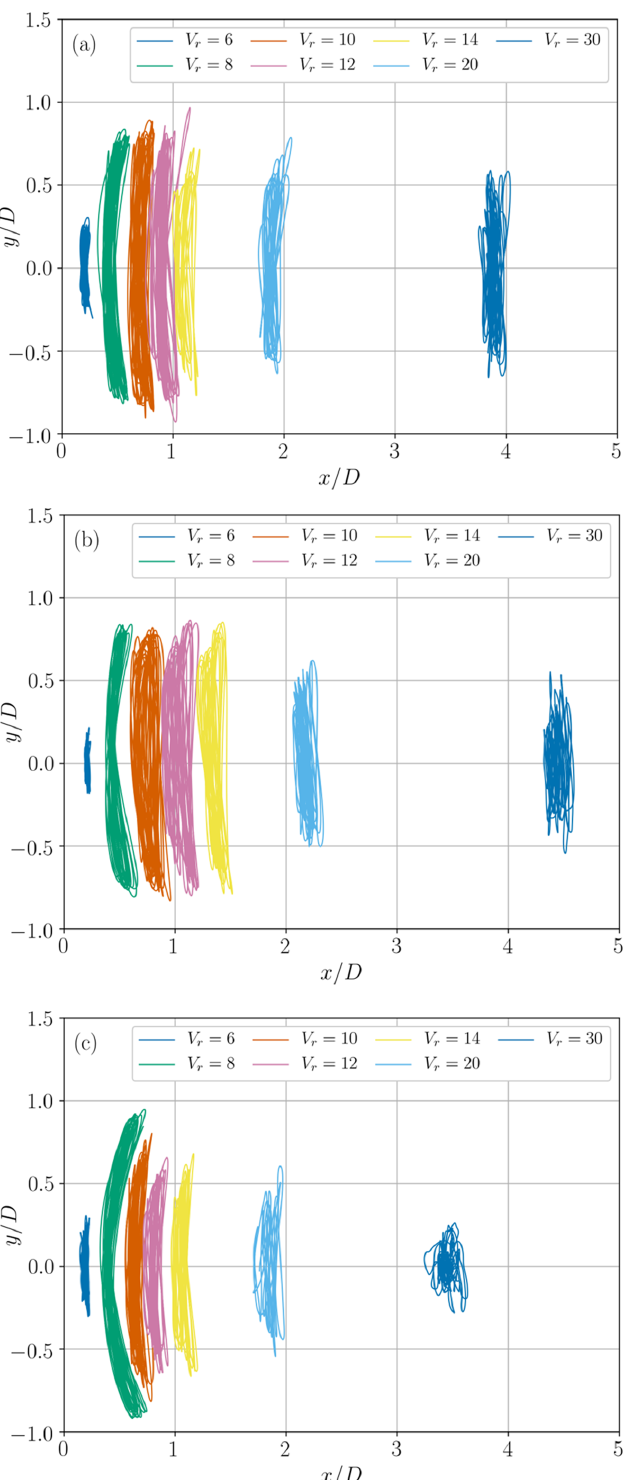
Figure 19. Motion trajectories of FOWT platform on XOY plane at various V